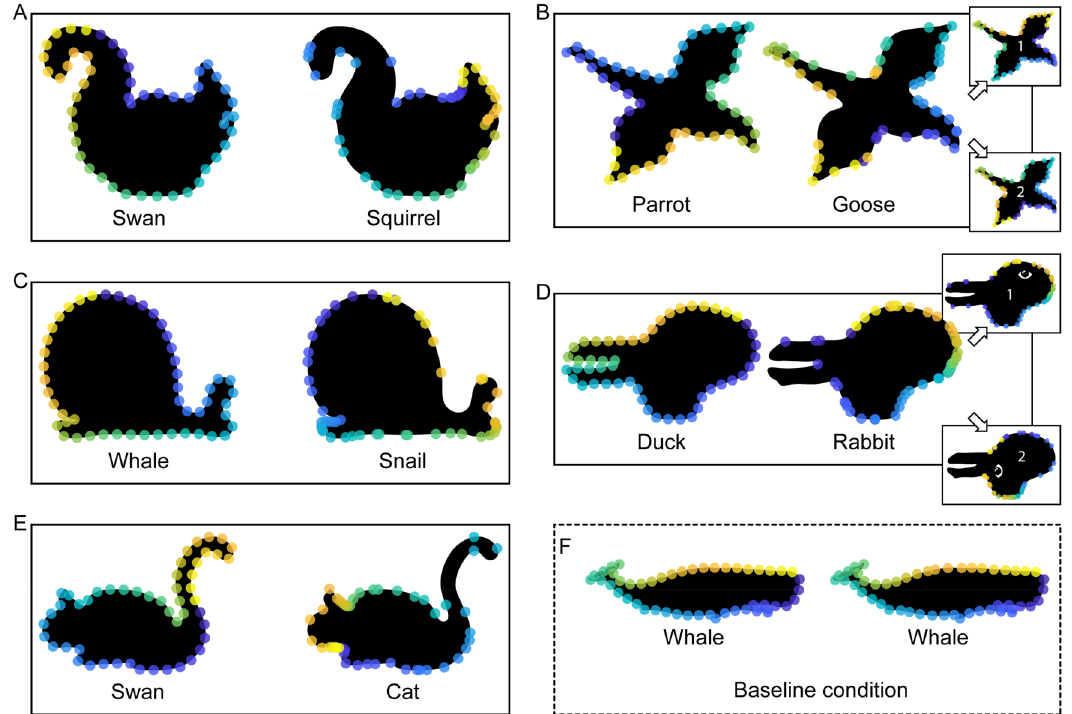
Figure 6. Overview of results of Experiment 2. On each base shape (left, e.g., swan), we plot the 50 equidistant probe points. On each test shape (right, e.g., squirrel), we plot the corresponding participant responses for each of the points. Participant responses are summarized by determining the median position along the length of the contour. ( A , C , E , F ) For most pairs and probe points, the order of points on the test shapes is the same as that on the base shape even though probe points were queried one at a time. ( B ) For the Parrot–Goose pair, we also show results separately for participants arranging their responses in the same (inset 1) or reversed order (inset 2) as the probe points. ( D ) For the Duck–Rabbit pair, we also show results separately for participants interpreting the rabbit as looking to the right (inset 1) or looking down (inset 2) (eyes added for illustration purposes). Data are available at https ://doi.org/10.5281/zenod o.43042